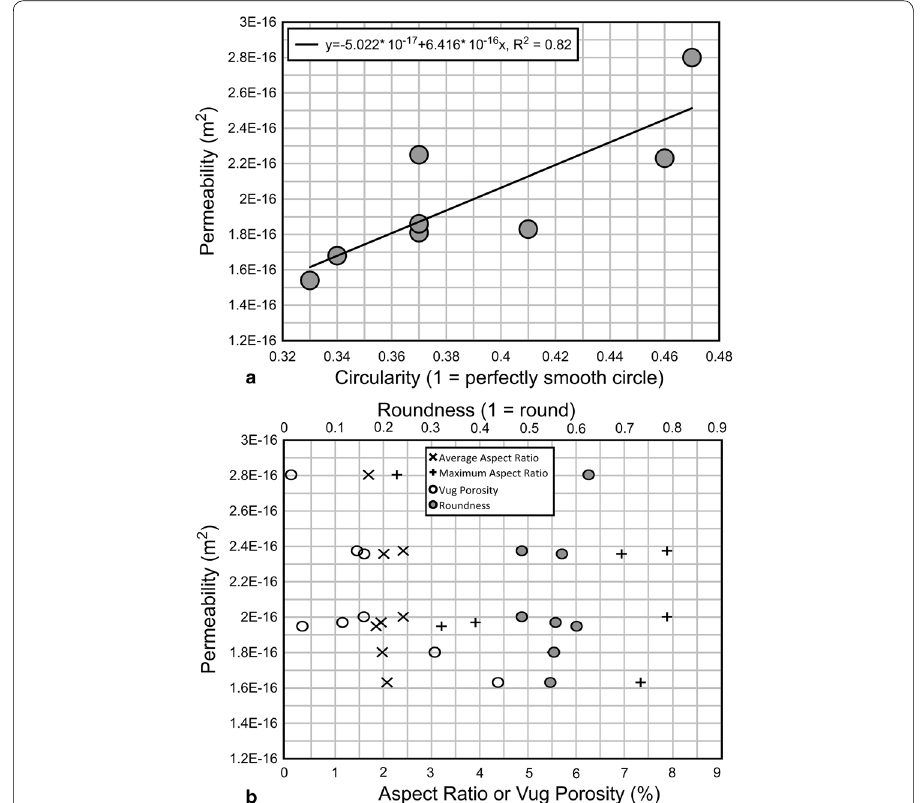
Fig. 6 Pore geometry measurements versus permeability at 5 MPa confining pressure for pore-dominated samples from NM 11 at 2083–2087.4 m depth. a circularity correlates with permeability; b aspect ratio, round- ness, and vug porosity do not correlate with permeability